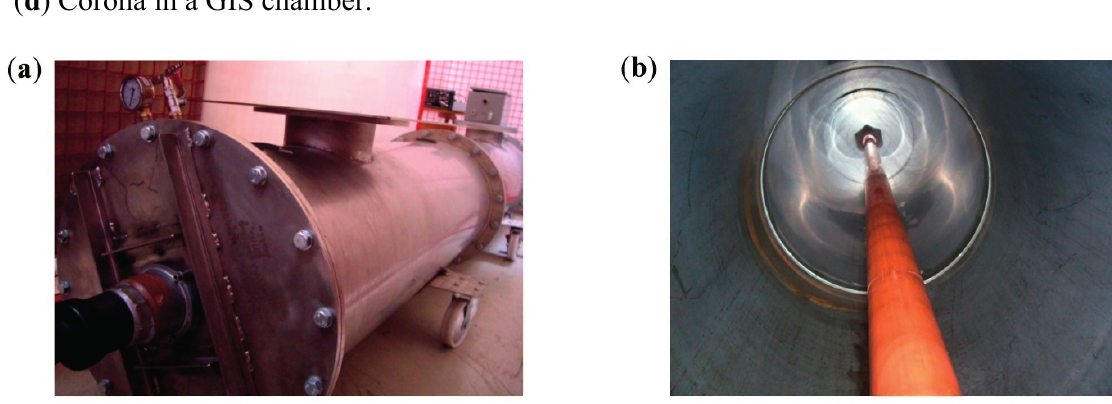
Figure 17. ( a ) Outside view of the GIS compartment; ( b ) Interior